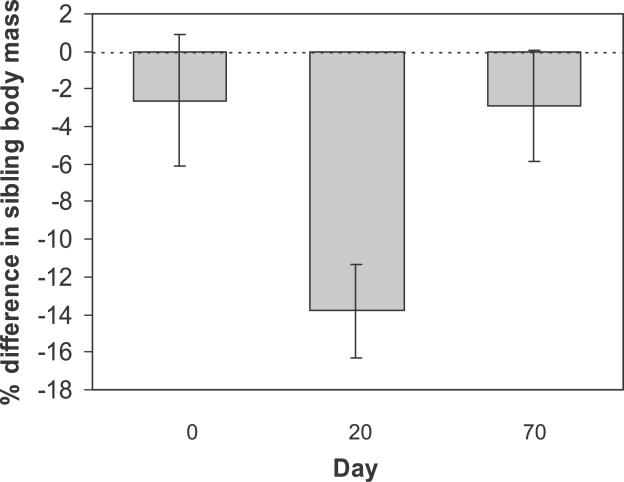
The Mean Difference in Body Mass between Pairs of Same-Sex Siblings at Different Stages of DevelopmentThe differences were calculated as the body mass of the D sib, which experienced the early nutritional deficit minus that of the N sib reared under normal conditions, and are expressed as a percentage of the N sib's body mass. Thus negative values indicate that the D sib is lighter than its N sib.